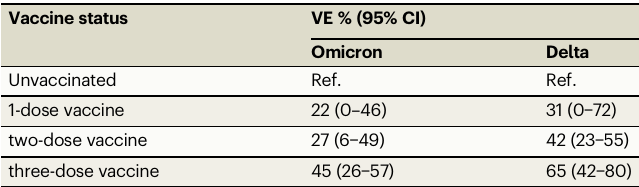
Table 2 | Vaccine ef fi cacy (VE) of Omicron and Delta by con- tact vaccination status (16+ years) Vaccine status